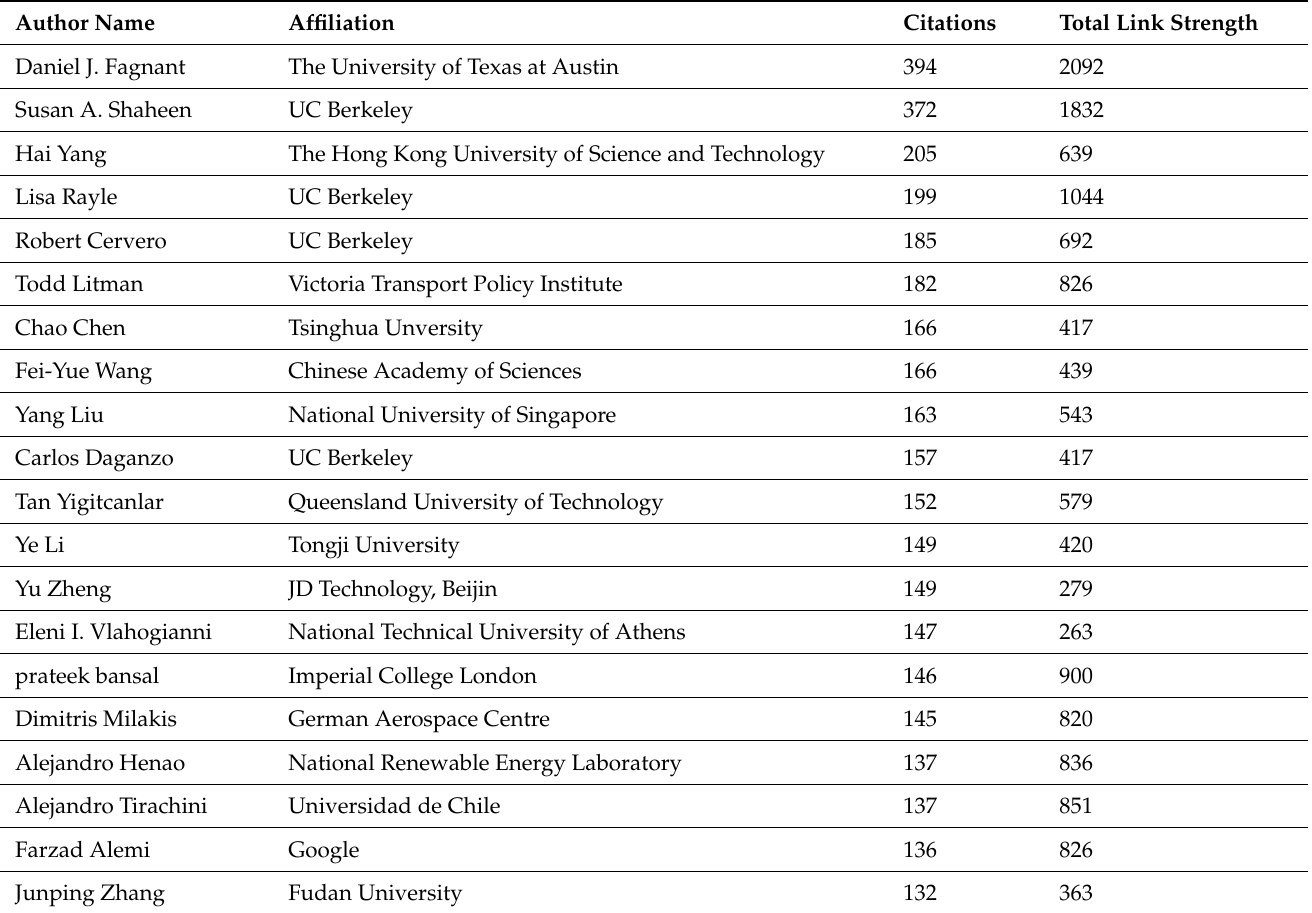
Table 2. Top 20 most influential authors on Smart Urban